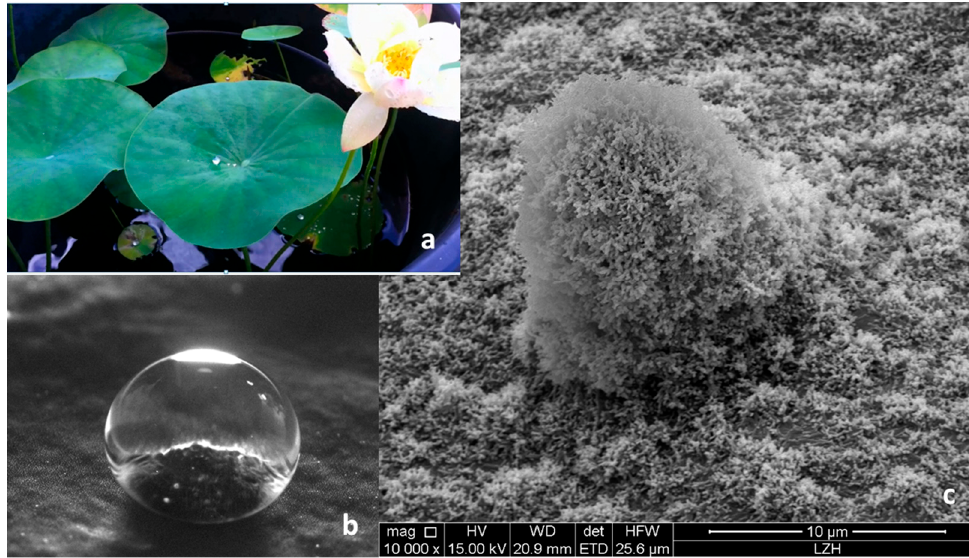
Figure 7. A flowering plant of the Lotus family ( Nelumbo nucifera ) ( a ); a spherical water droplet on a superhydrophobic leaf ( b ); SEM image of the lotus leaf surface ( c ).